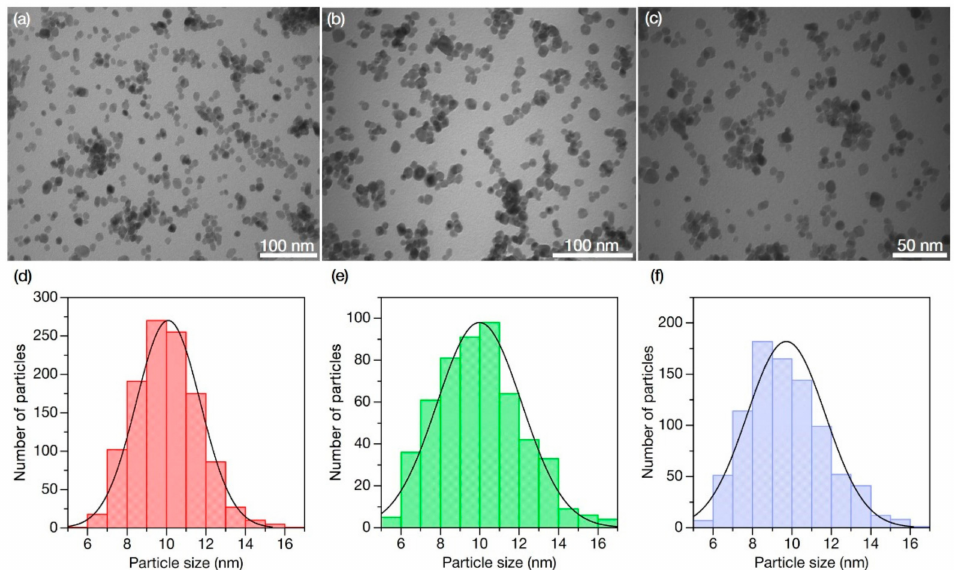
Figure 3. TEM images of ( a ) BaGdF 5 :Eu, ( b ) BaGdF 5 :Tb, and ( c ) BaGdF 5 :Sm; Particle size distribution of ( d ) BaGdF 5 :Eu, ( e ) BaGdF 5 :Tb, and ( f ) BaGdF 5 :Sm according to TEM